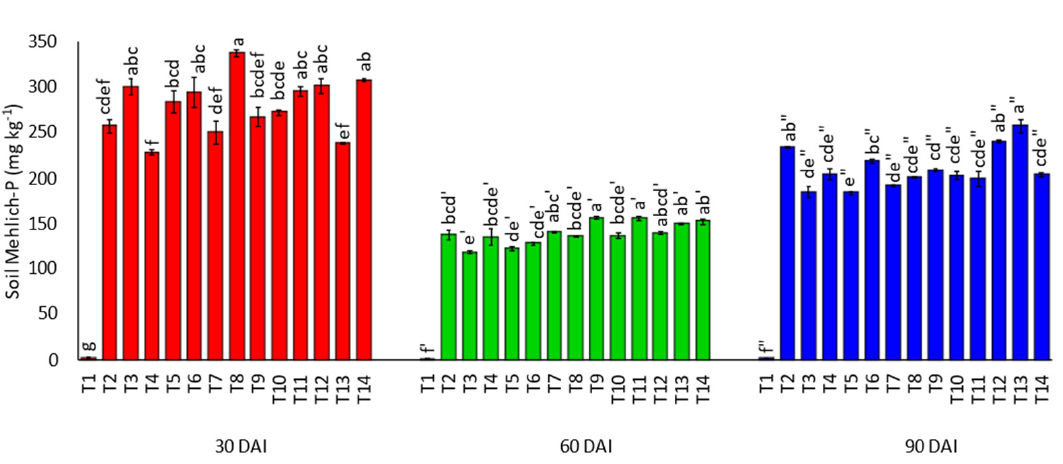
Figure 15. Effects of treatments on soil Mehlich-phosphorus after thirty, sixty, and ninety days of incubation, where T1: soil alone, T2: Egypt rock phosphate alone, T3: Egypt rock phosphate + 100% charcoal, T4: Egypt rock phosphate + 100% sago bark ash, and T5: Egypt rock phosphate + 100% charcoal + 100% sago bark ash, T6: Egypt rock phosphate + 75% charcoal + 75% sago bark ash, T7: Egypt rock phosphate + 50% charcoal + 75% sago bark ash, T8: Egypt rock phosphate + 25% charcoal + 75% sago bark ash, T9: Egypt rock phosphate + 75% charcoal + 50% sago bark ash, T10: Egypt rock phosphate + 50% charcoal + 50% sago bark ash, T11: Egypt rock phosphate + 25% charcoal + 50% sago bark ash, T12: Egypt rock phosphate + 75% charcoal + 25% sago bark ash, T13: Egypt rock phosphate + 50% charcoal + 25% sago bark ash, and T14: Egypt rock phosphate + 25% charcoal + 25% sago bark ash. Means with different letter(s) within the same incubation period indicate significant differences between treatments according to Tukey’s HSD test at p ≤ 0.05, i.e., a > b > c. Bars represent the mean values ± SE.